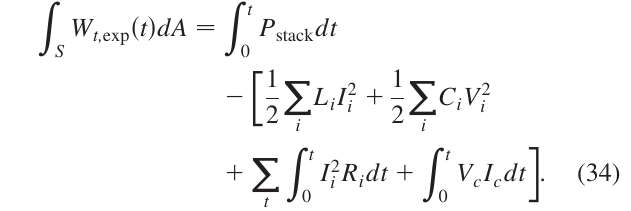
FIG. 3. (Color) Cross-sectional view of the system of stainless- steel conductors fielded as the load on Z-accelerator-shots 507, 532, and 589. The illustration is to scale. Except for the on-axis post, the conductors are 0.3-cm thick. The outer radius of the conductors is 5.38